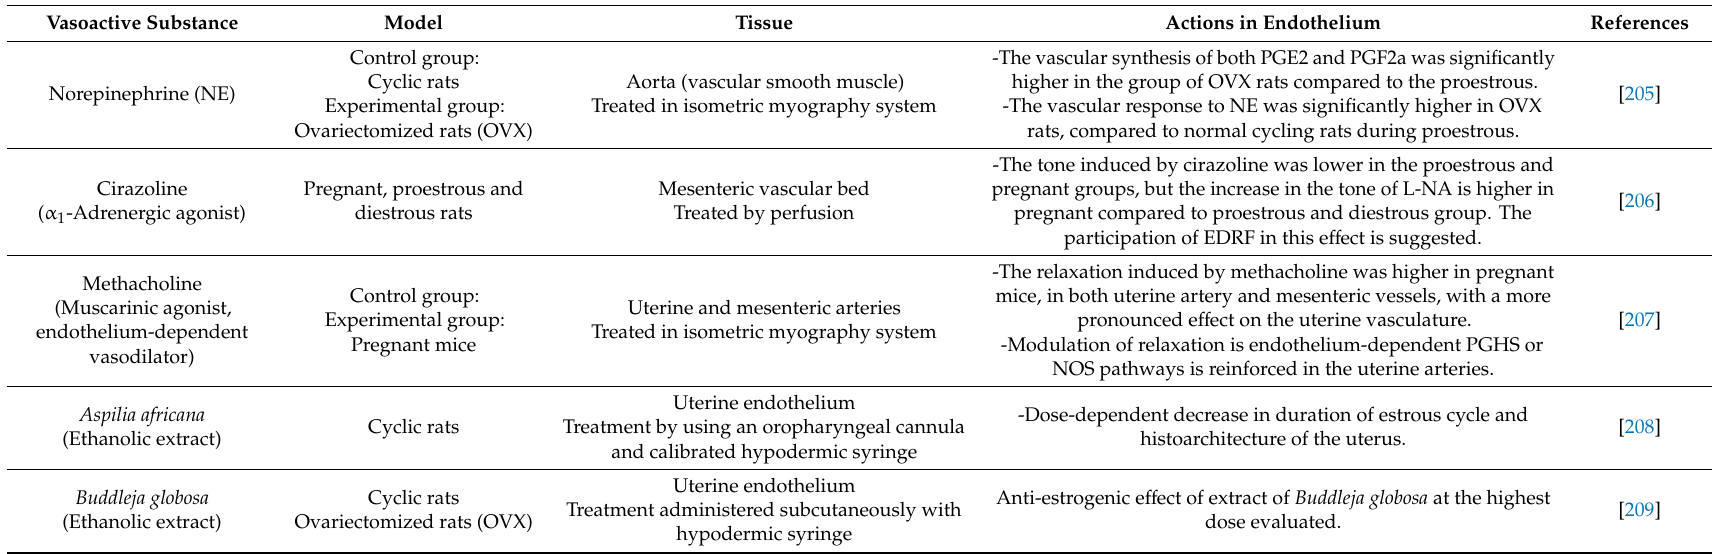
Table 2. Some vasoactive substances capable of modulating vascular tone in di ff erent endothelial